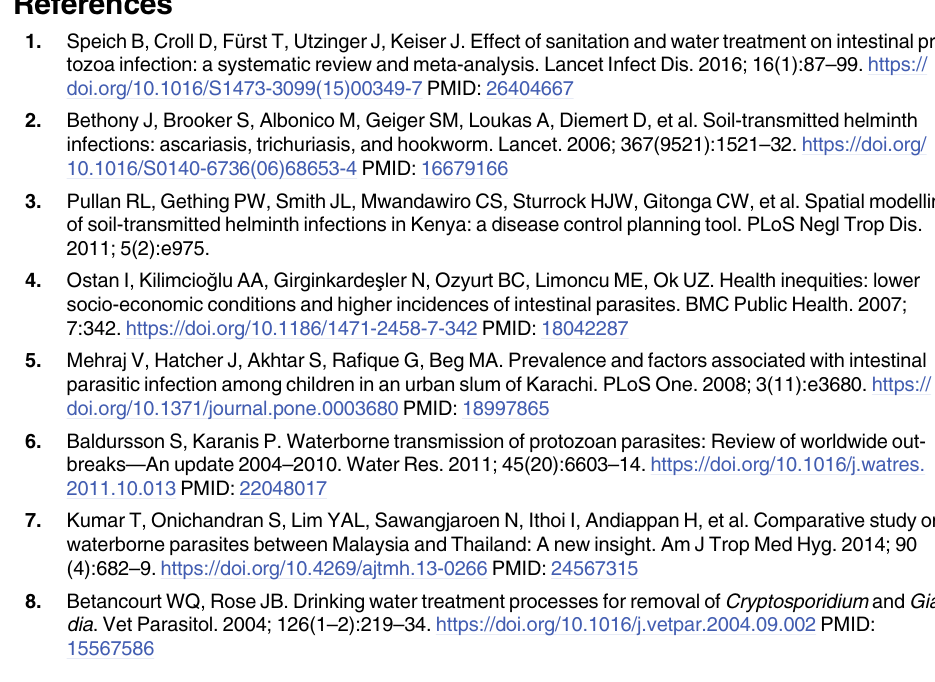
S2 Table. Number of positive and negative participants to intestinal parasites by regions. S1 Fig. Population density of Rio de Janeiro